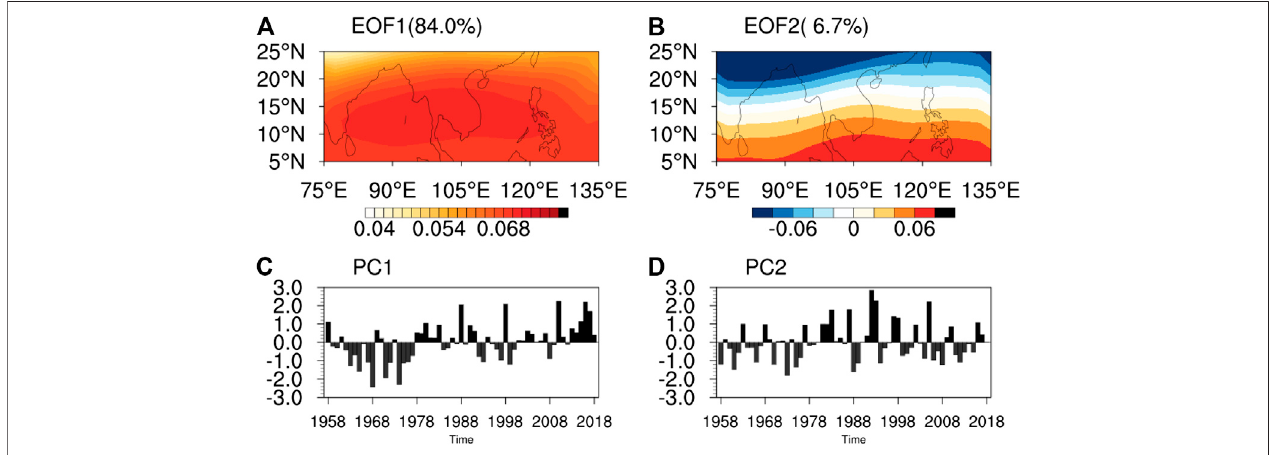
FIGURE 6 | Spatial distribution of (A) the fi rst EOF mode (shaded), (B) the second EOF mode (shaded), and (bottom) the corresponding PCs of 150 hPa geopotential height anomalies in May from 1958 – 2018.